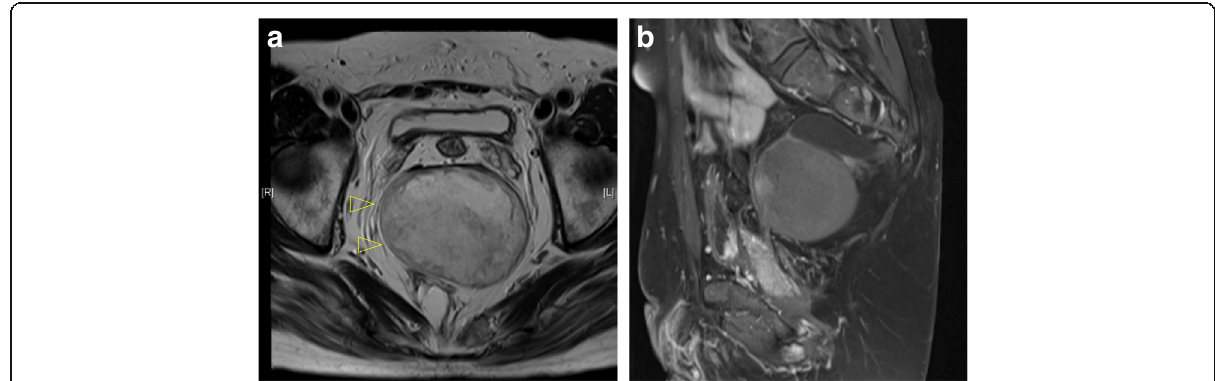
Fig. 2 Magnetic resonance imaging (MRI). The inside of the cystic tumor ( △ ) showed heterogeneously high intensity in T2-weighted image ( a ) and homogenously low intensity in T1-weighted image. The wall was enhanced by Gadolinium ( b